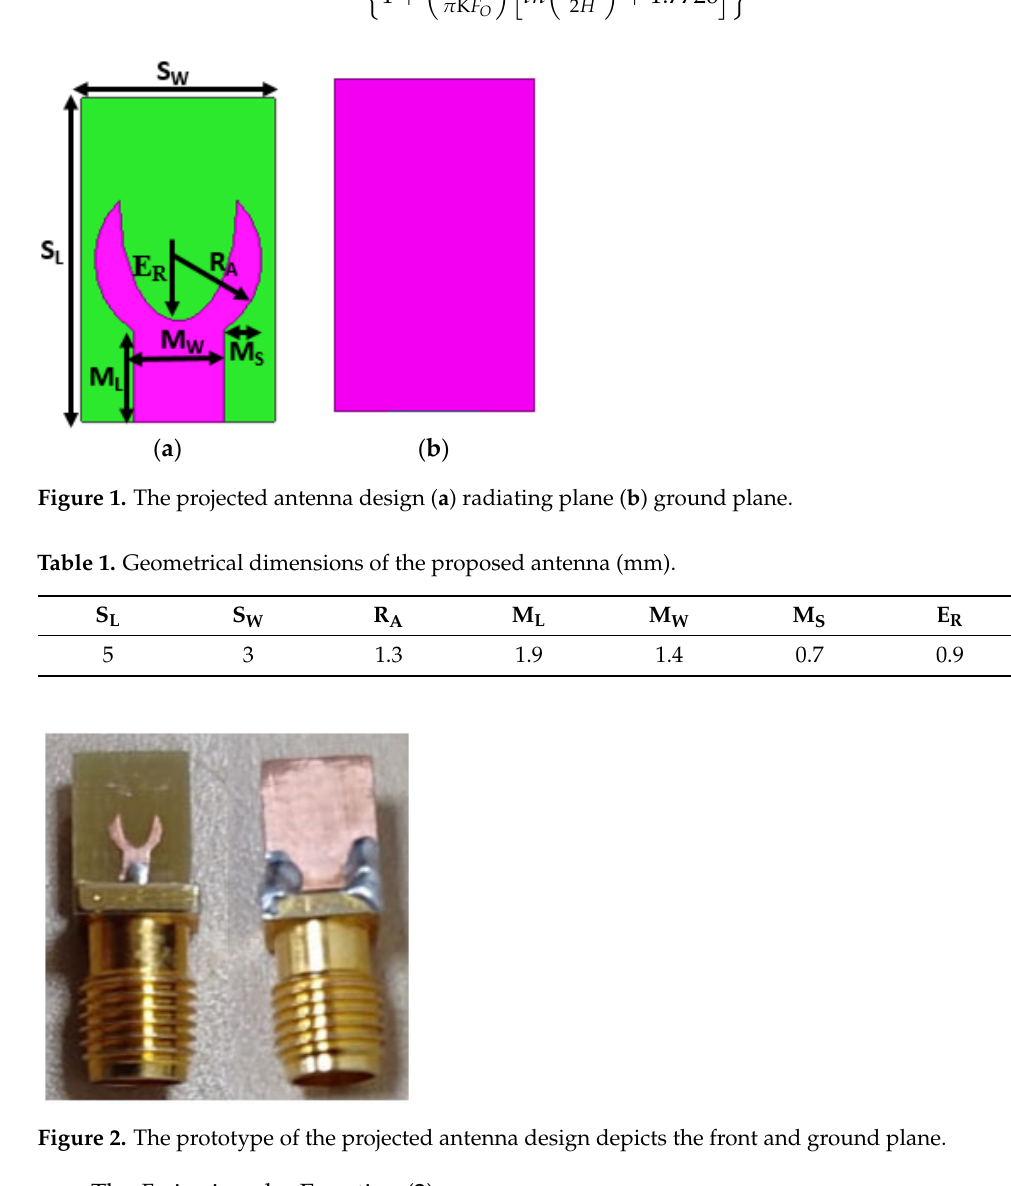
Table 1. Geometrical dimensions of the proposed antenna (mm).